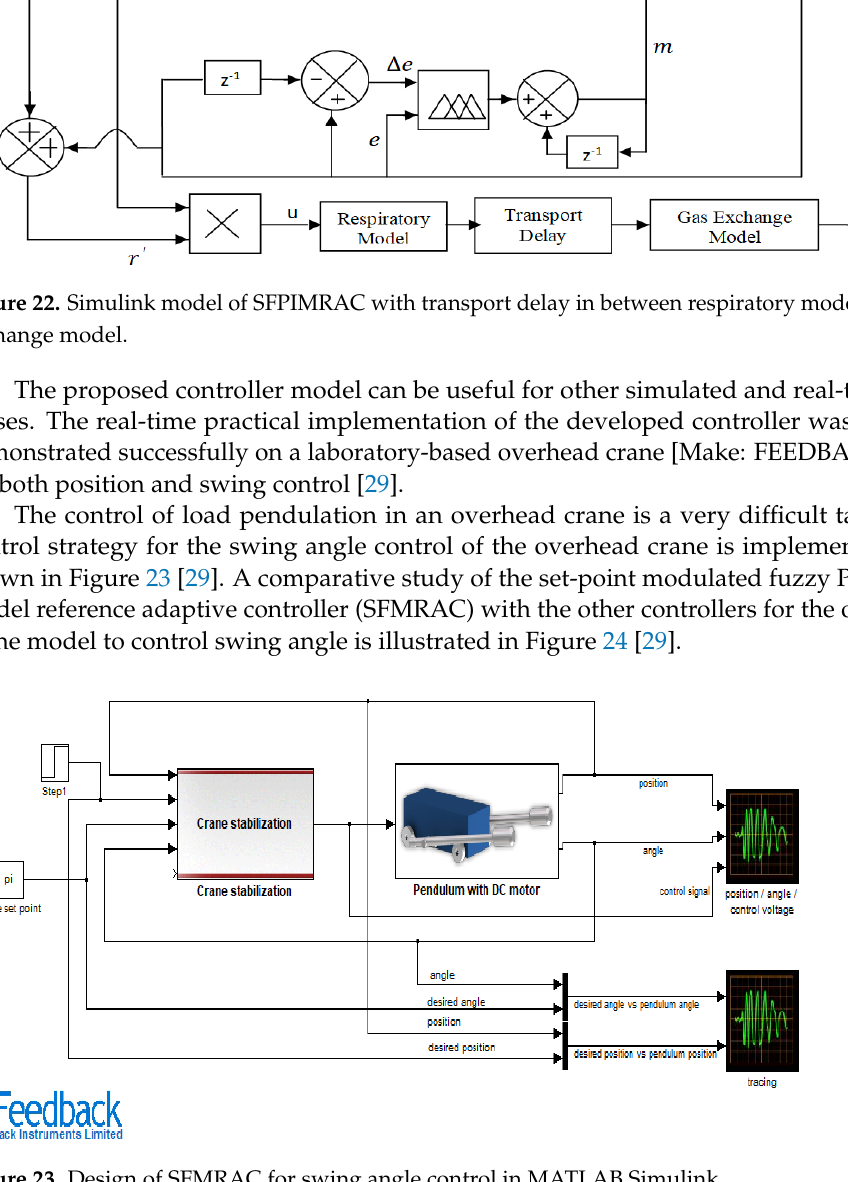
Figure 21. Response with SFPIMRAC for transport delay and load/set ‐ point variations.